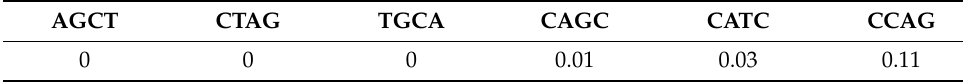
Table 2. Absent or under-represented tetramers in the Hardycor1 genome 1 .